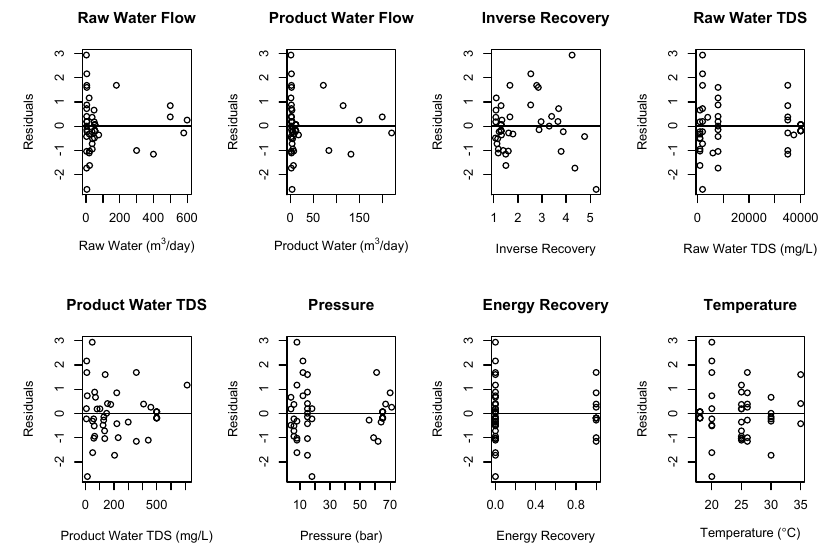
Figure A1. Residual plots for the small-scale desalination multiple linear regression model show some heteroscedasticity, but little trending as